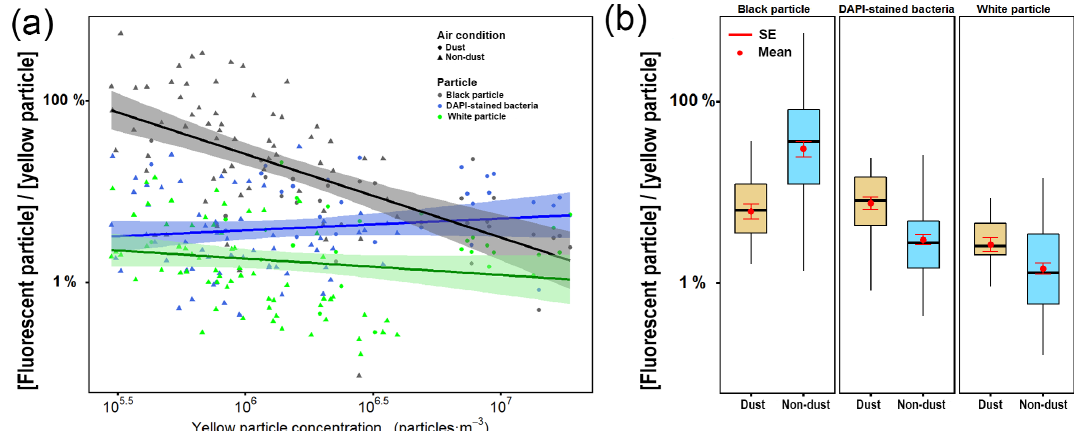
Figure 10. The concentration ratios of the other three kinds of fluorescent particles to the yellow particles (a) and a comparison of these ratios in the dust and non-dust samples (b) (SE: standard error; the y axis is spaced logarithmically).